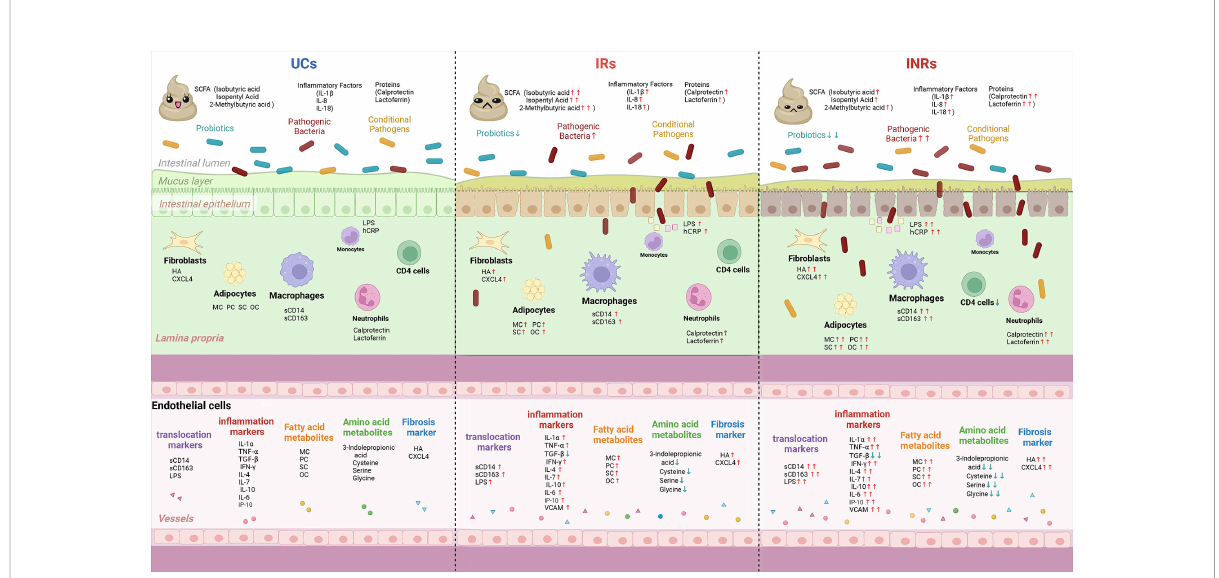
FIGURE 3 Schematic summary of microbial translocation, immune cells involved, and altered circulating markers in UCs, IRs, and INRs. UCs, uninfected controls; IRs, immune responders; INRs, immune non-responders; SCFA, short chain fatty acids; sCD14, soluble CD14; sCD163, soluble CD163; IL-6, interleukin-6; IL-7, interleukin-7; IL-7R, interleukin-7 receptor; IL-1 a , interleukin-1 a ; IL-1 b , interleukin-1 b ; IL-8, interleukin-8; IL-18, interleukin-18; IP-10, interferon-inducible protein 10; LPS, lipopolysaccharide; hsCRP, hypersensitive C-reactive protein; TGF- b , transforming growth factor- b ; VCAM, vascular adhesion molecules; HA, hyaluronic acid; CXCL4, C-X-C motif chemokine ligand 4; MC, myristyl carnitine; PC, palmitoylcarnitine; SC, stearoylcarnitine; OC, oleoylcarnitine; ↑ , increase in comparison with uninfected controls; ↓ , decrease in comparison with uninfected